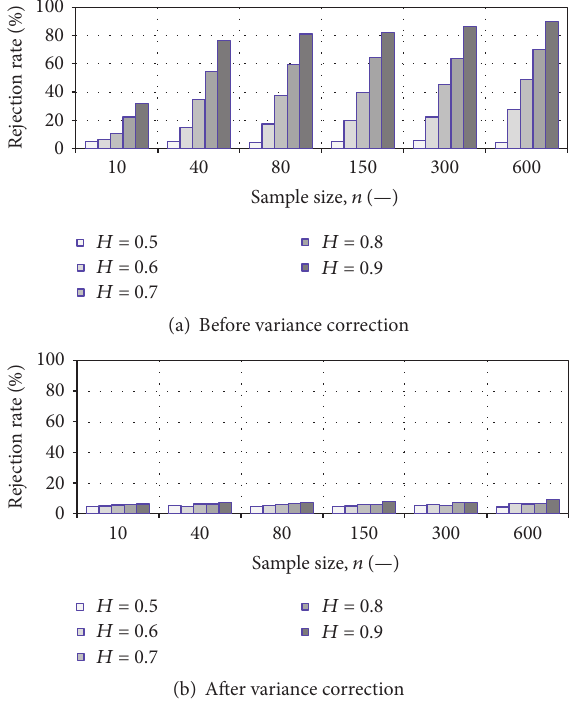
Figure 11: Rejection rate of the CRD test (a) before and (b) after the correction of the 𝑉(𝑇) for the influence of the long-term persistence on